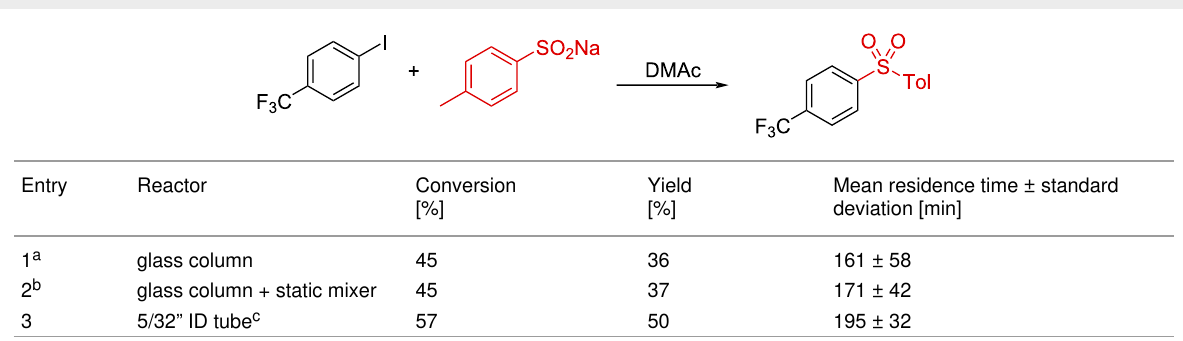
Table 2: Comparison of different reactors.